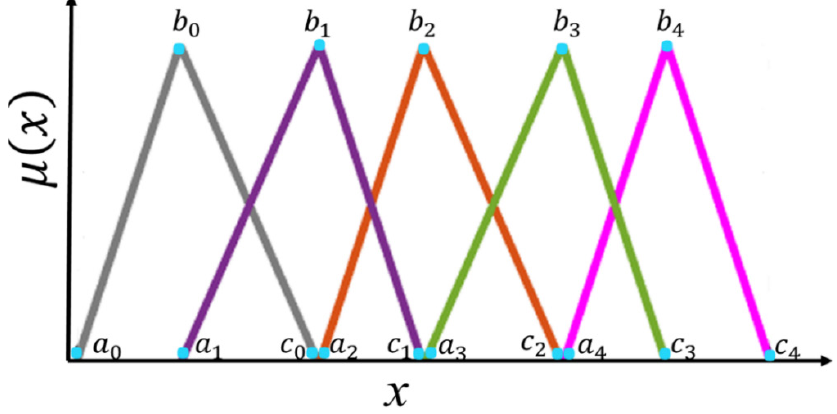
Figure 4. Parameters of the membership functions of the Output 1 and Output 2.